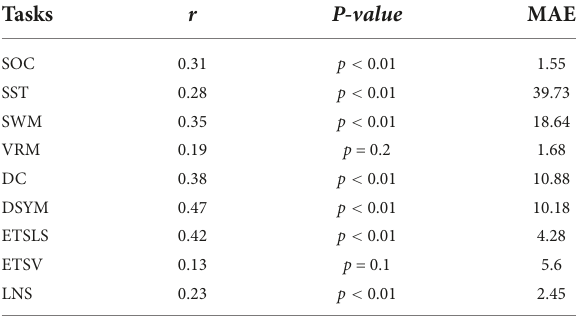
TABLE 3 Predicting cognitive functions of elder group using models based on younger group.